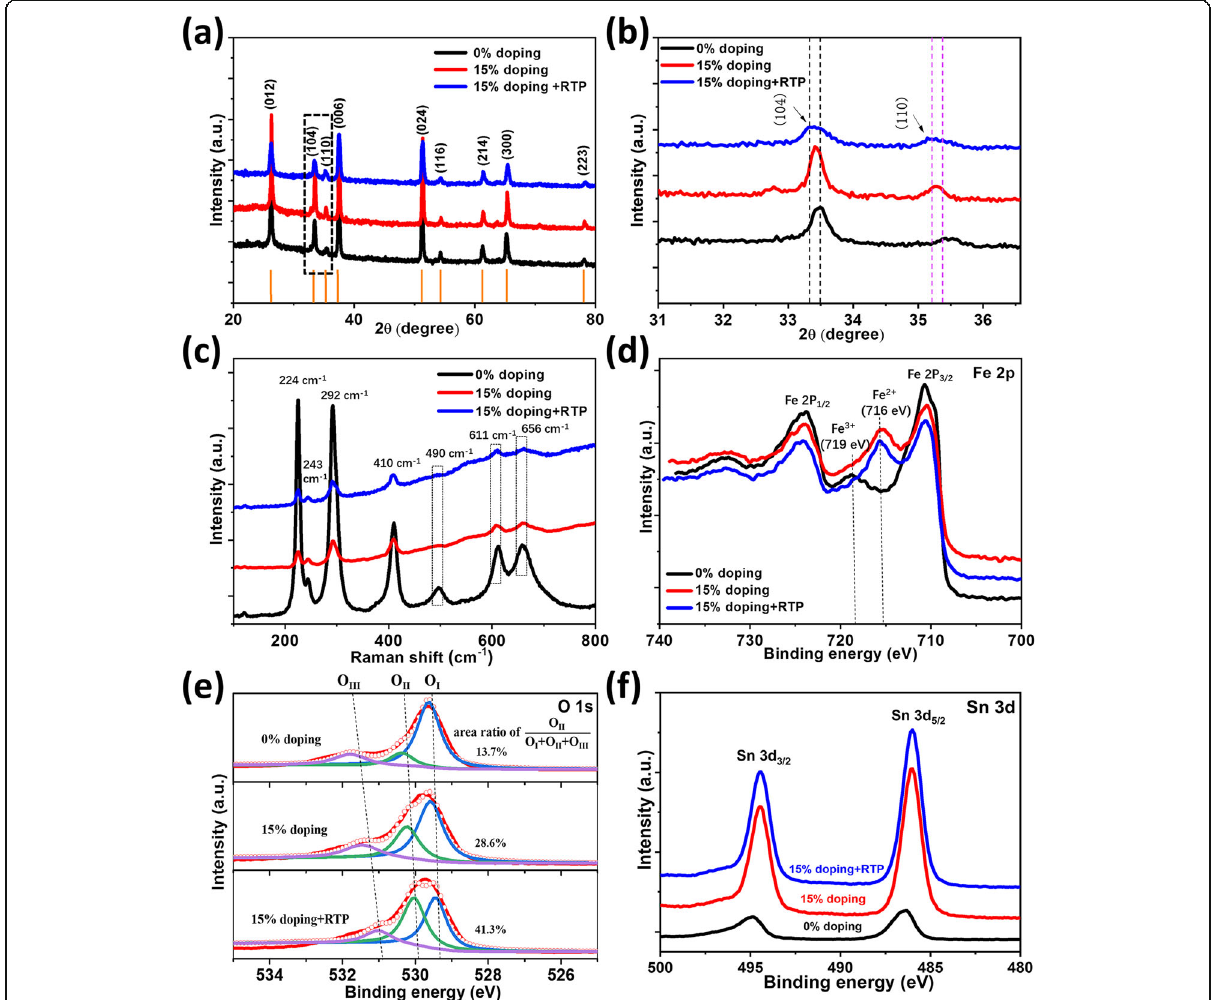
Fig. 2 a XRD patterns. b Locally enlarged image of a indicated by the dashed line box. c Raman spectra and XPS spectra of d Fe 2p. e O 1s and f Sn 3d in various hematite